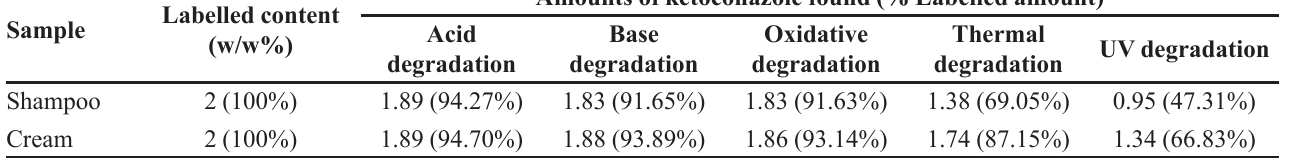
TABLE VI - Results of stress degradation of ketoconazole